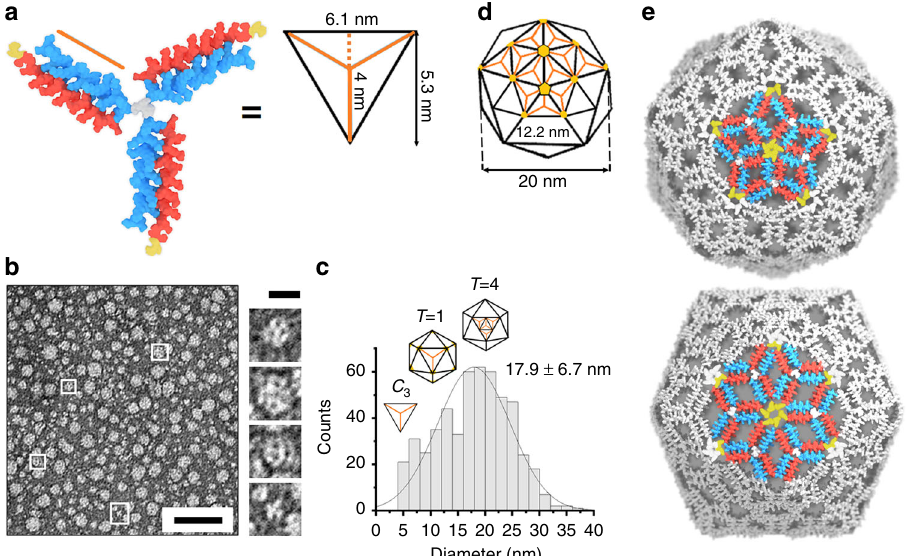
Fig. 3 Capsid-like assembly of the C 3 -subunit. a Molecular model of the C 3 -triskelion (PDB entry 4DMD rendered by Macromodel Schrödinger). Each subunit of the triskelion corresponds to the altitude of an equilateral triangle. A folded subunit spans ~4 nm (three coiled-coil heptads extended with the arm of the dendrimer hub and the cysteine cap), which makes the side of the hosting triangle ~6.1 nm. b High-resolution electron micrographs for C 3 (+) strand (100 µ M) assembled with C 1 ( − ) strand at 1:3 molar ratio, with individual structures highlighted by white squares. Scale bars are 100 nm for the large panel and 20 nm for the four inset images of individual assemblies. c Diameter distributions of the assembled capsids with corresponding sizes calculated for the triskelion fi tted into a triangular facet ( C 3 ) and T capsids. d T = 4 icosahedron with four facets in each triangular face with each accommodating one triskelion. For clarity, only a partial network of triskelions in the icosahedron is shown. Five- and six-fold axes are highlighted by yellow diamonds. The diameter of the icosahedron and the side of its triangular face are calculated based on the triskelion dimensions shown in a . e Model of a T = 4 capsid assembled from the C 3 -subunit with parameters matching those from a and d . For clarity, only one of fi ve- and six-fold axes each is shown in colour and with